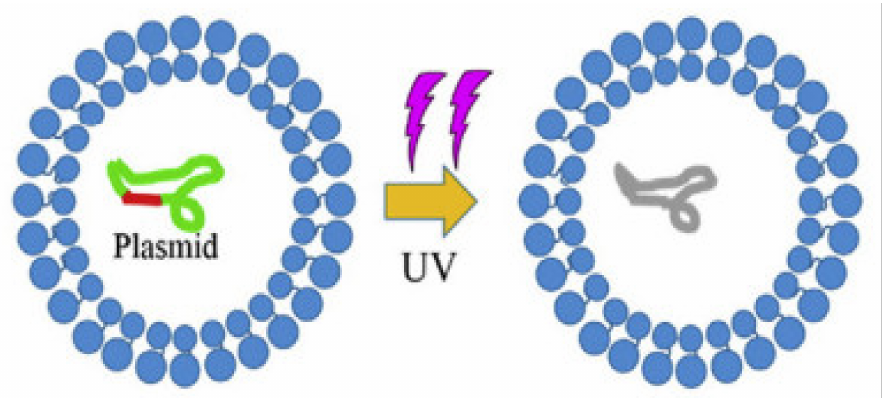
Figure 2. Mechanisms of UV disinfection affecting ARG conjugation and transfer (adapted from Guo et al.